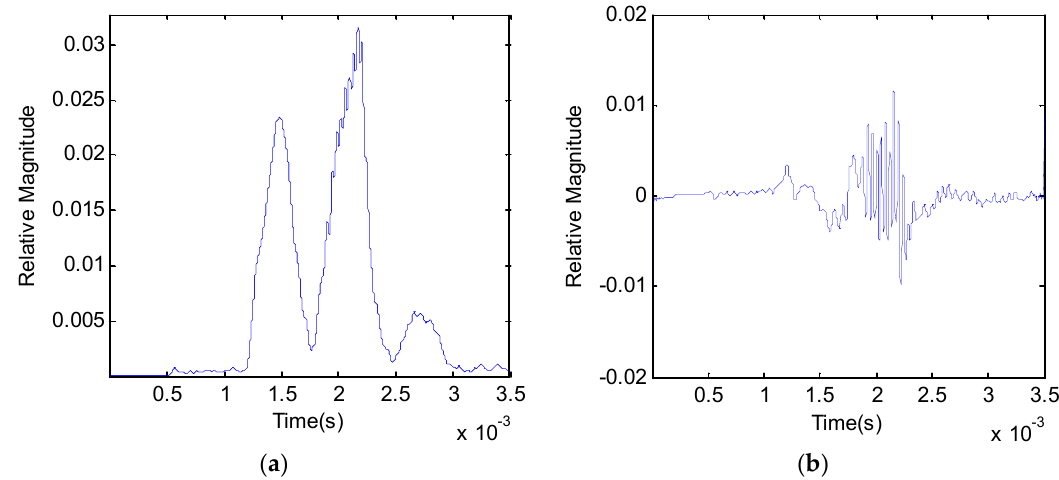
Figure 17. ( a ) A synthetic echo envelope with LFM 40–80 kHz frequency; ( b ) gradient of the synthetic echo envelope from ( a ).